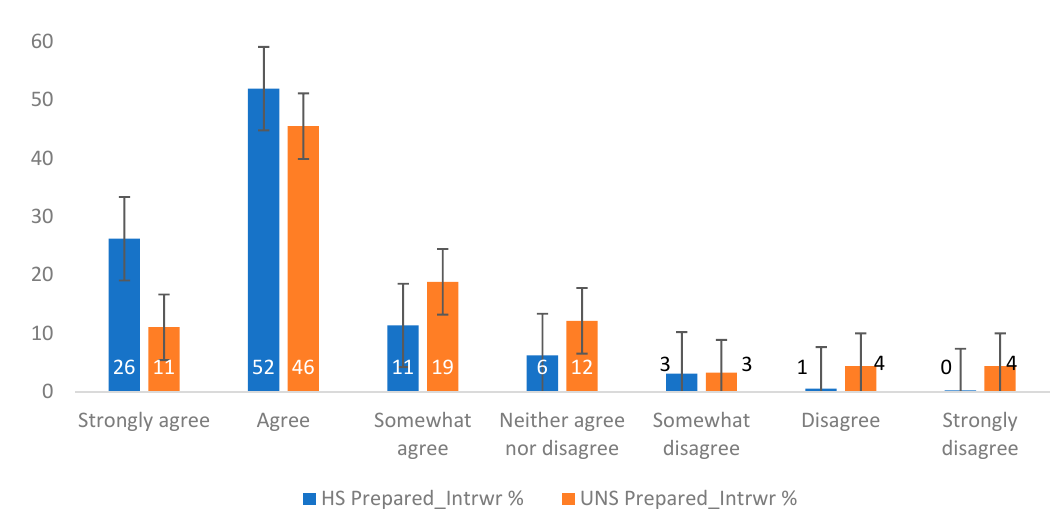
Table 7. Applicant Perspective Hypothesis 5—Interviewer’s preparation.